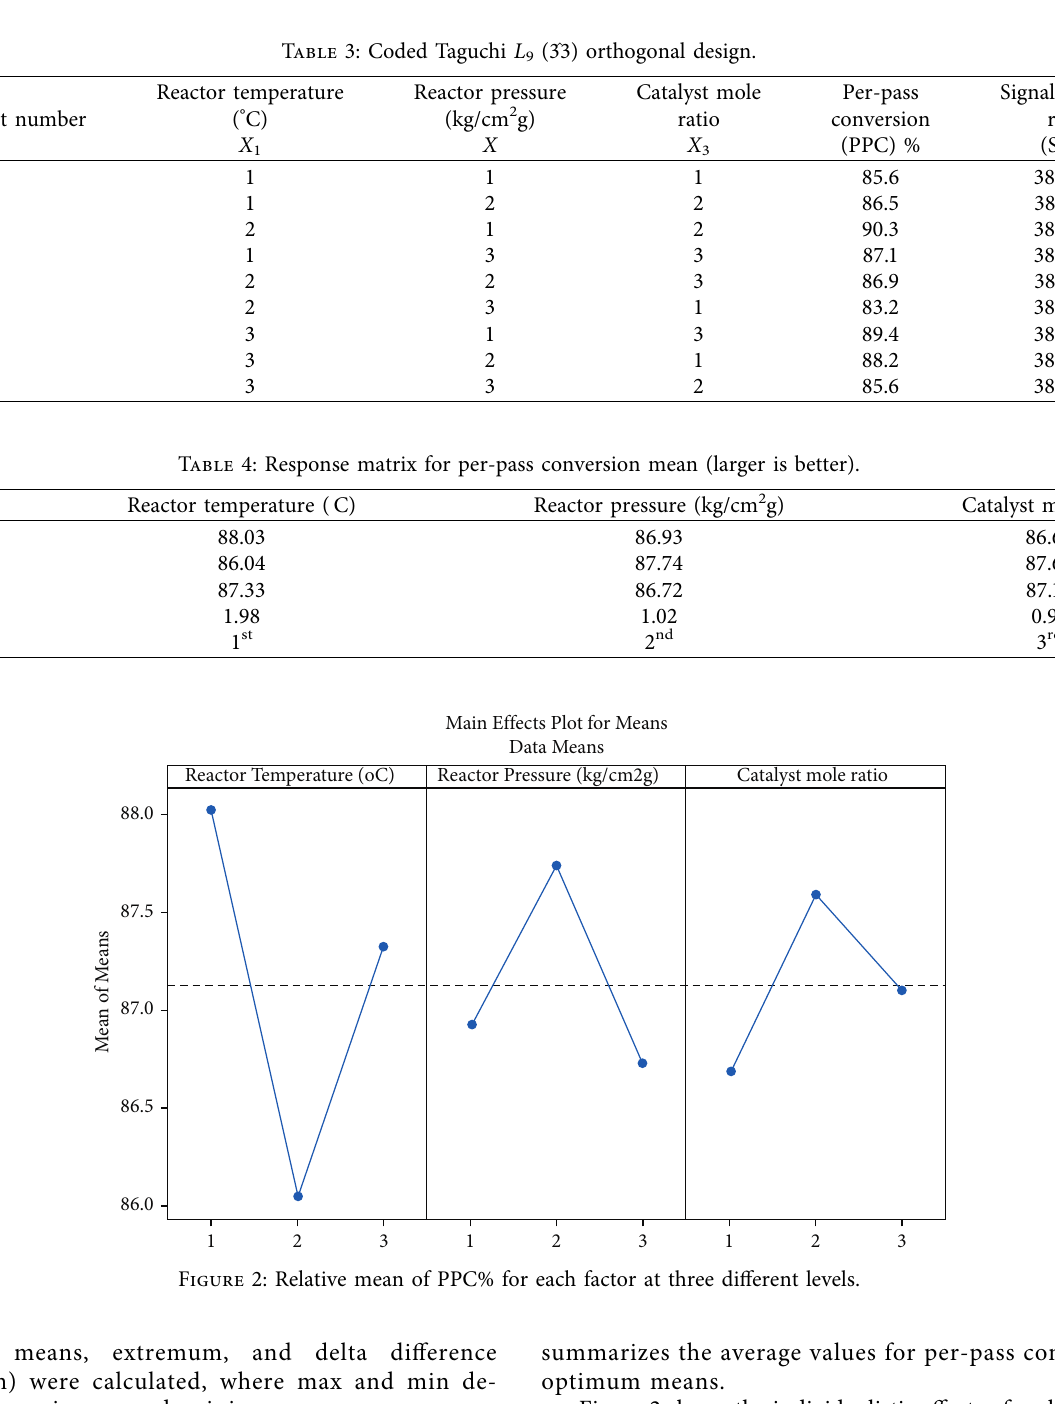
^ 3) orthogonal design. 9 (3